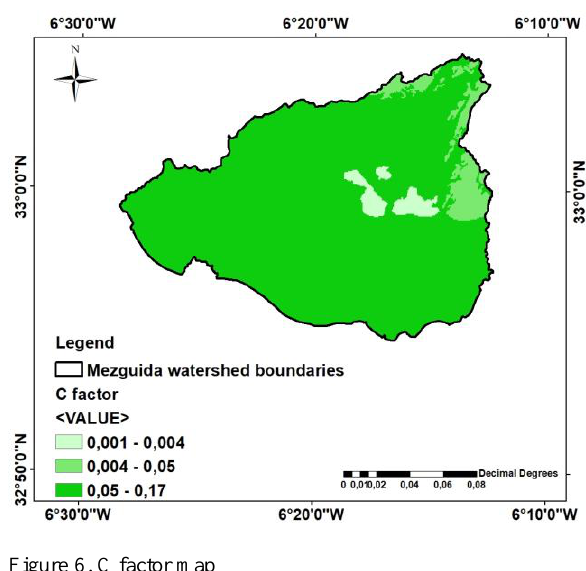
Figure 6. C factor map